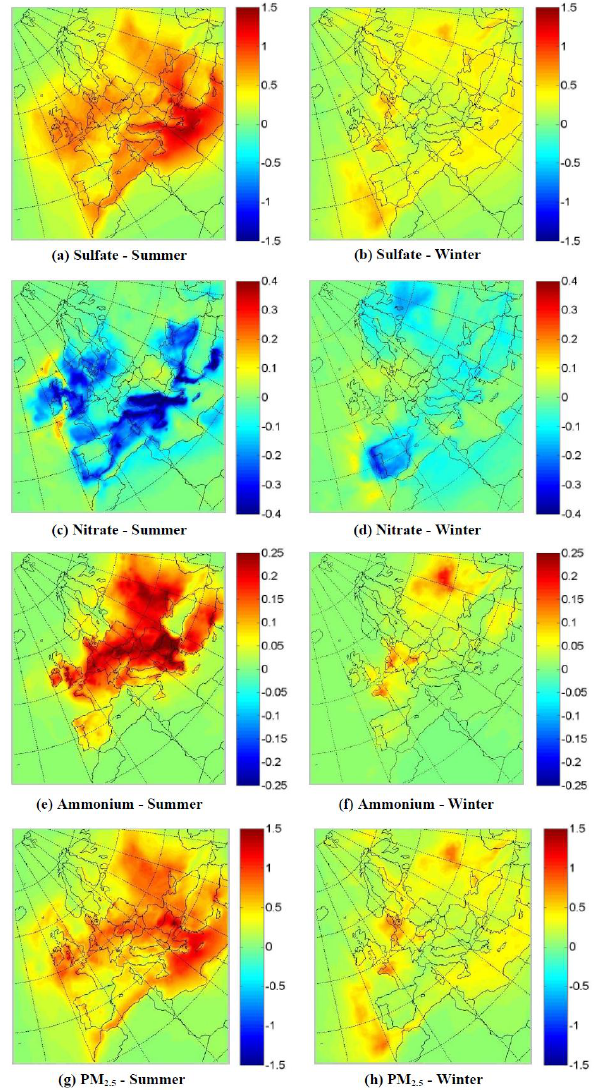
Fig. 6. Predicted reduction (base case – emissions reduction sce- Figure 6. Predicted reduction (base case - emissions reduction scenario) in ground-level 3 nario) in ground-level concentrations (µgm − 3 ) of (a–b) sulfate, (c– concentrations (μg m -3 ) of (a-b) sulfate, (c-d) nitrate, (e-f) ammonium, and (g-h) total PM 2.5 4 d) nitrate, (e–f) ammonium, and (g–h) total PM 2 . 5 after a 50% re- after a 50% reduction of SO 2 emissions during the modeled summer and the modeled winter 5 duction of SO 2 emissions during the modeled summer and the mod- period. A positive value corresponds to a decrease. 6 eled winter period. A positive value corresponds to a decrease.